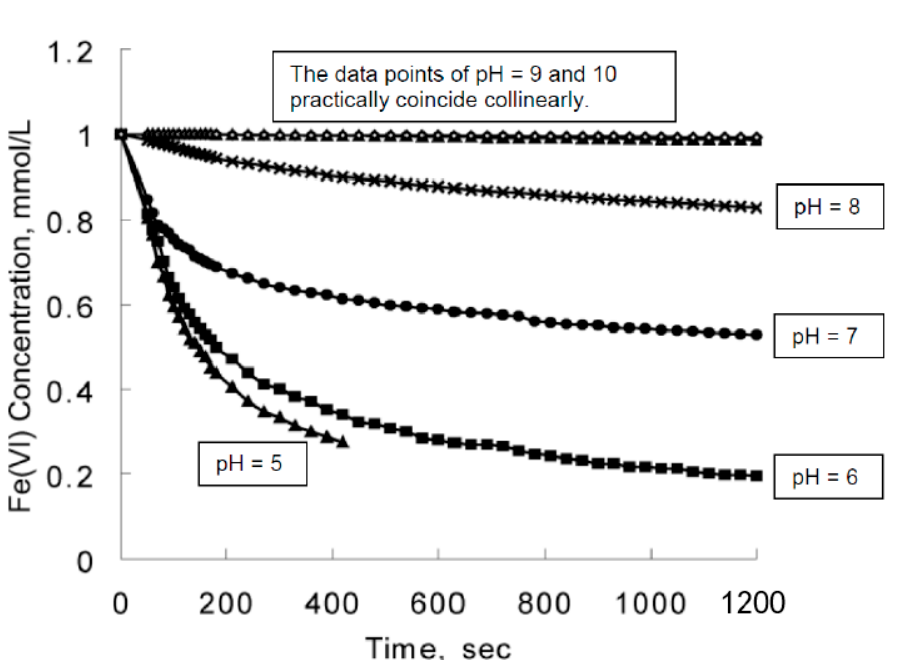
Figure 13. Rate of decomposition of ferrate(VI) as a function of pH [83].